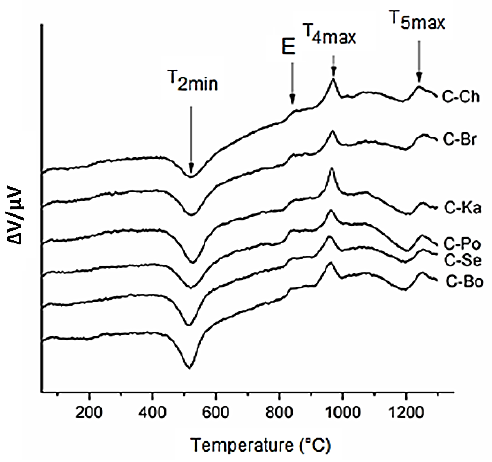
Figure 3. XRD patterns of ceramic samples C-Se and C-Po. The peaks of indialite are unmarked and enstatite is marked with arrow. A non-crystalline phase area is separated from the background by a dashed line.